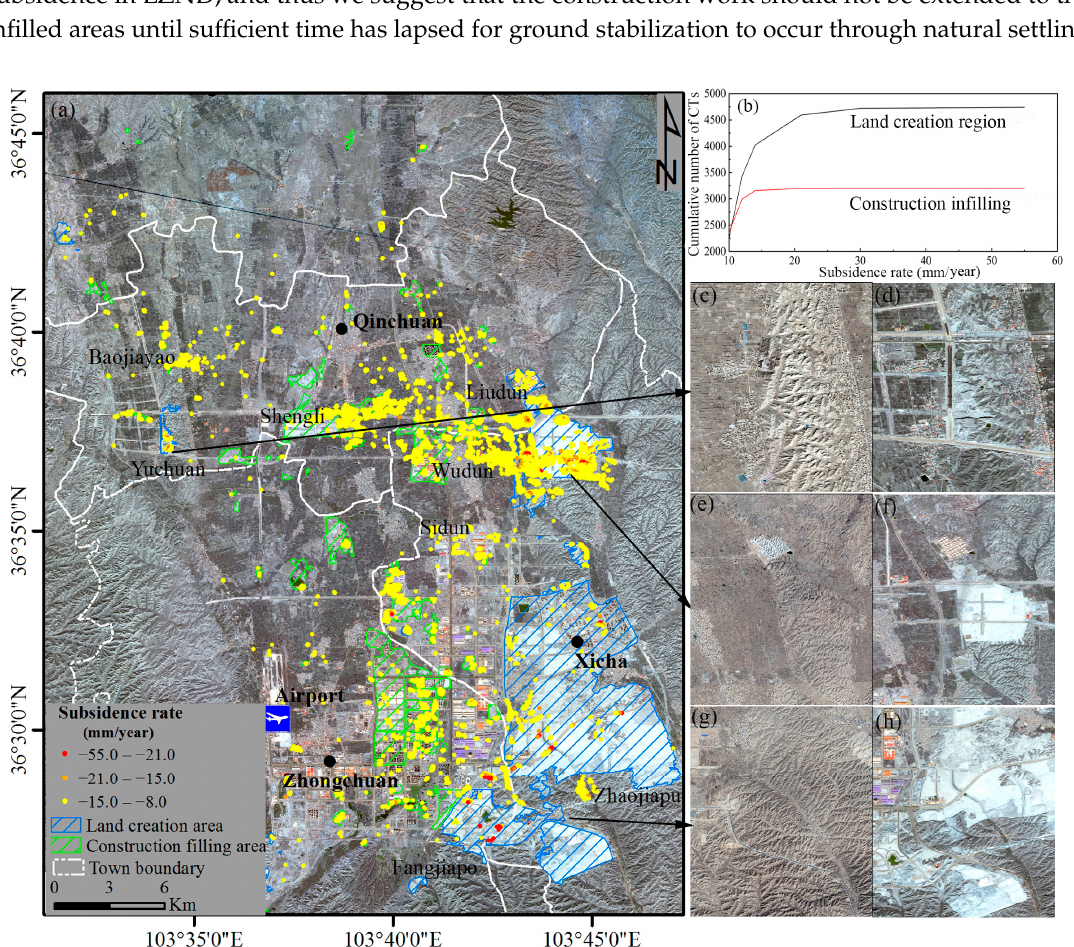
Figure 8. Land creation and construction infilling in relation to subsidence in LZND: ( a ) subsidence rate during 2015–2016 and different land reclamation types; ( b ) subsidence rate and cumulative number of CTs for different land reclamation types; ( c – f ) enlarged views for the three major land creation zones; ( c , e , g ) images extracted from the Google Earth satellite obtained on 3 March 2013; and ( b , f , h ) images extracted from the GF-1 satellite acquired on 17 October 2016.